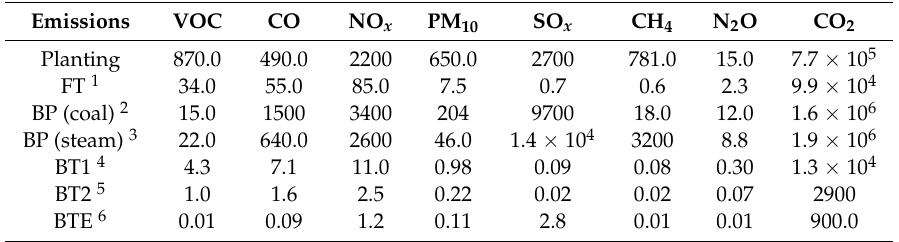
Table 6. Emissions from the planting, transport and bioethanol production units (g/ethanol